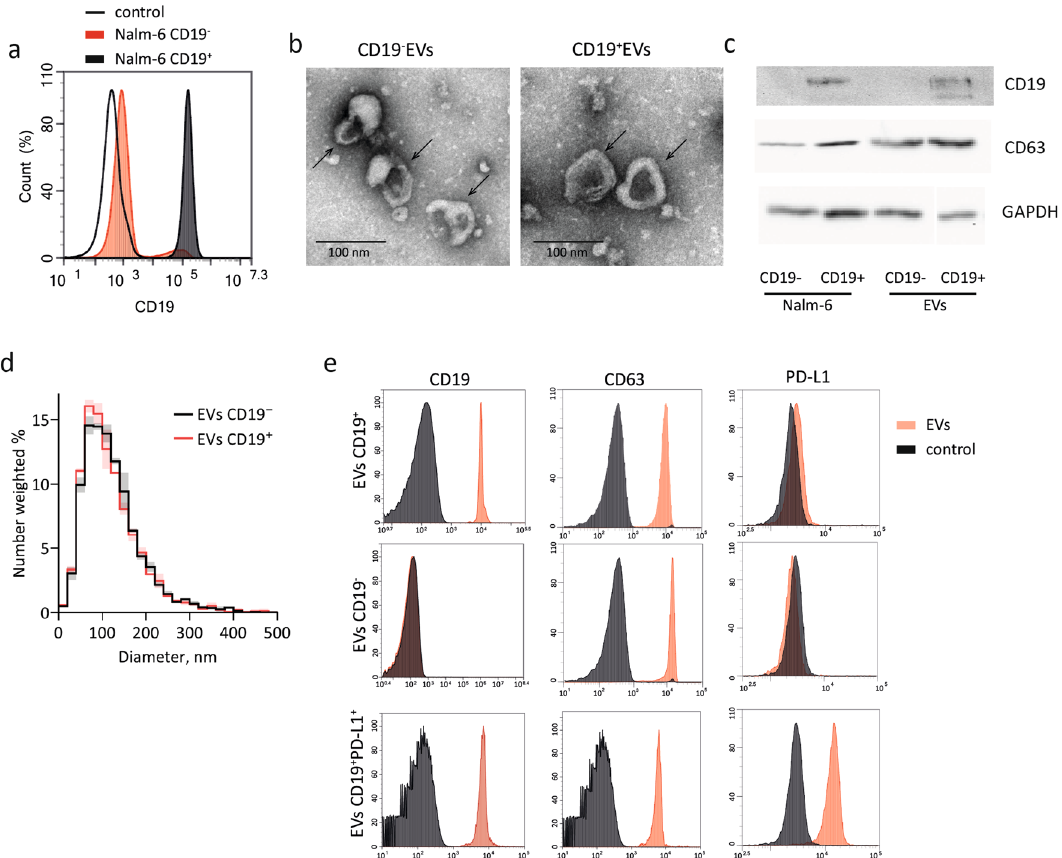
Figure 1. Characterization of EVs isolated from tumor cells. ( A ) CD19 + and CD19 − Nalm-6 cells were stained with anti-CD19 antibody conjugated with PE-Cy7 and analyzed by flow cytometry. Results are plotted as histograms. Background fluorescence of unstained control cells is shown as black line. ( B ) Cropped TEM images of purified CD19 + and CD19 − EVs. Original images are presented in Supplementary Figure 6B. ( C ) Western blot analysis of CD63 and CD19 expression in Nalm-6 total protein extract and extracts prepared from samples of purified EVs. Cropped images are presented. Aliquots of protein extracts were separated by SDS-PAGE, GAPDH was used for loading control and normalization. Original blots/gels are presented in Supplementary Figure 6A. ( D ) Histograms of size distribution of isolated EVs determined by NTA. Solid lines show mean values and shading represent SD for two independent samples. ( E ) Detection of EVs surface protein markers (CD19, CD63, PD-L1) on EVs captured on the surface of magnetic beads conjugated with anti-CD81 IgGs. Grey histograms show fluorescence of control empty beads stained with corresponding